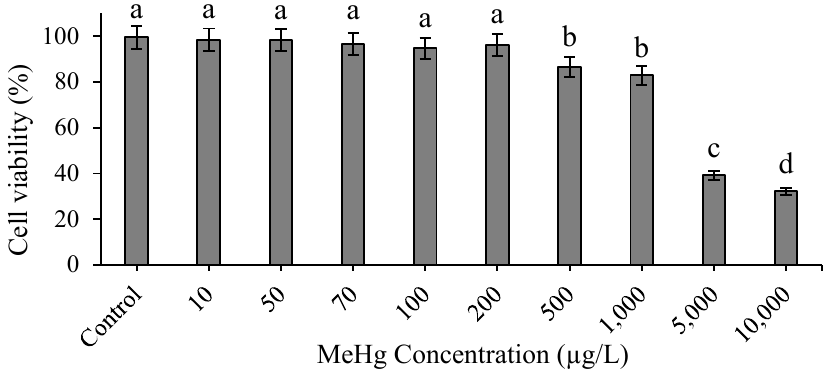
Figure 1. Cell viability of hybrid grouper leukocytes after in vitro incubation with various concentrations of methylmercury for 30 min. One-way ANOVA and Tukey’ test were performed to compare the differences between groups. Values are presented as mean ± SD ( n = 3). Significant differences ( p < 0.05) between treatment groups are indicated by different letters above the bars.